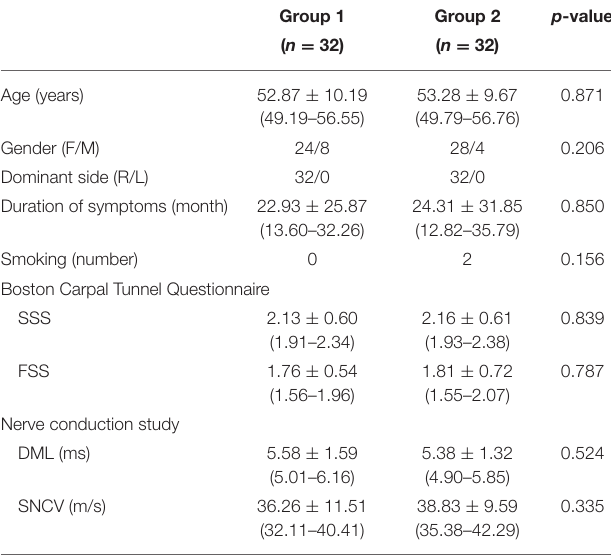
TABLE 1 | Baseline characteristics of the